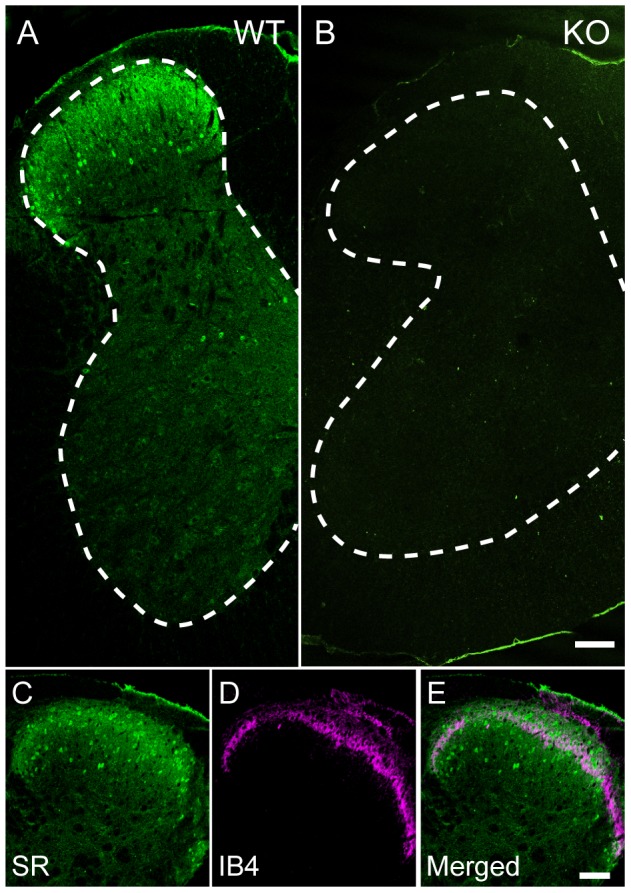
Distribution of immunofluorescence staining of serine racemase (SR) in lumbar spinal cord.(A) SR (green) is mainly distributed in the superficial part of the dorsal horn of the WT mice. (B) No SR signals (green) are detected in the spinal cord of the SR-KO mice. The dorsal part is the upper side. The bar indicates 100 µm in A and B. (C-E) The double immunofluorescence staining of SR (green) and IB4 (magenta), a marker of lamina II of the dorsal horn, indicates that SR is predominantly distributed in lamina II. The bar indicates 75 µm in C-E. The dotted lines in A and B are the outline of the gray matter of the spinal cord.